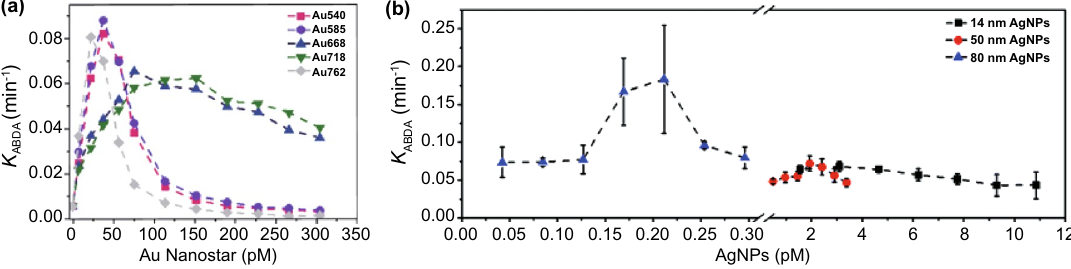
Fig. 15 Plot of kinetic constant based on degradation of ABDA (kABDA) versus different concentration of metal nanoparticles showing the plasmonic enhancement effect on the singlet oxygen generation (SOG) efficiency of a AIE-PS nanodots (2 μg mL −1 ) on Au nanostars with different maximum extinction peaks, reproduced from Ref. [21] with permission from Nature-Springer. b Red-emissive AIE-PS molecule on AgNPs, reproduced from Ref. [22] with permission from Royal Society of